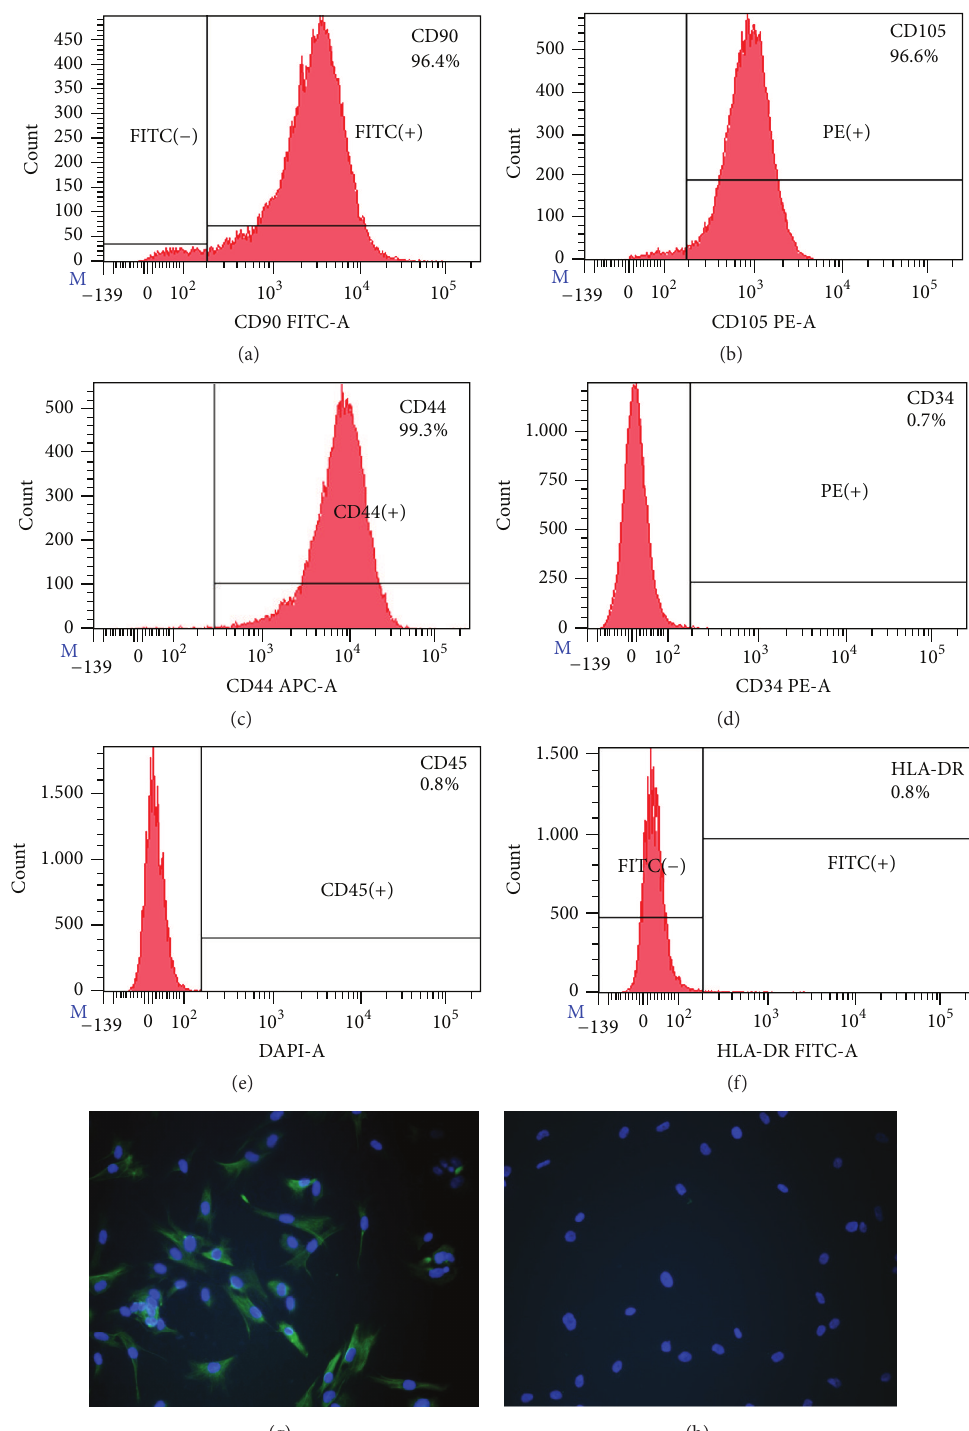
Figure 4: In vitro characterization of pituitary adenoma cell cultures for mesenchymal stromal cell markers. Representative FACS histograms of pituitary somatotroph adenoma cell culture (a–f). Cells were positive for CD90 (a), CD105 (b), and CD44 (c) and were negative for CD34 (d), CD45 (e), and HLA-DR (f). Representative immunostaining of VIM (green) (g) and negative control (h). Nuclei were stained with DAPI (blue). 200x magnification. CD90, Thy-1 cell surface antigen; CD105, endoglin; CD44, CD44 molecule (Indian blood group); CD34, CD34 molecule; CD45, protein tyrosine phosphatase, receptor type, C; HLA-DR, major histocompatibility complex, class II,